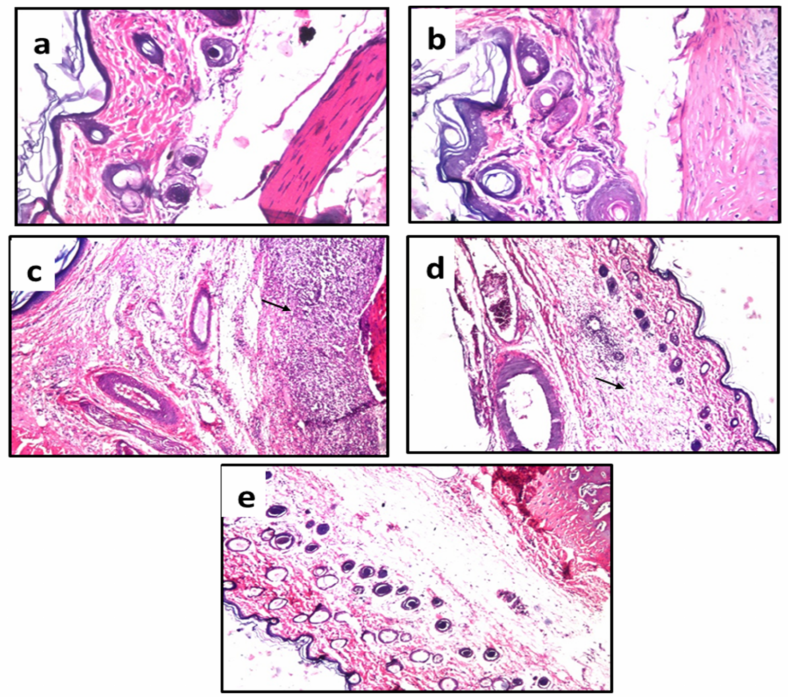
Figure 2. Photomicrographs of subcutaneous and dermal tissues of treated rats. ( a ) control group; ( b ) indomethacin group; ( c ) carrageenan group; ( d ) group receiving oral 200 mg/kg of J. integerrima leaves extract; and ( e ) group receiving oral 400 mg/kg of J. integerrima leaves extract. Arrows refer to inflammatory cell infiltration.